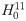
CpG frequencies for each dinucleotide position (black line) for H011 (panel a), H114 (panel b) and H216 (panel c) of the human genome.CpG frequencies for present sequences of the same length (green line) are also reported in the three panels.